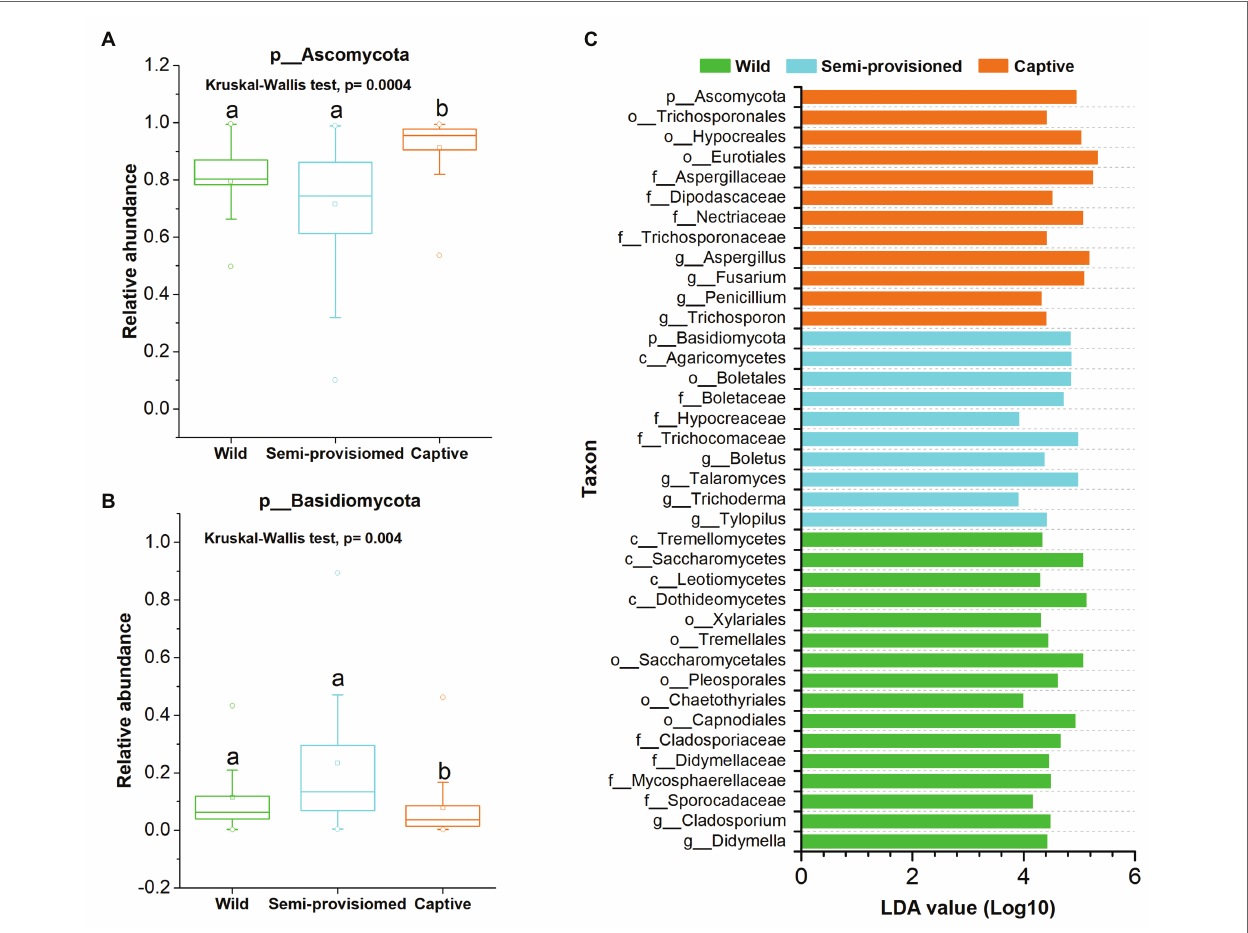
FIGURE 3 | Variation of fecal fungal taxonomy across three study groups. (A) Comparison of the dominant phyla Ascomycota. (B) Comparison of the dominant phyla Basidiomycota. A Kruskal-Wallis ANOVA test was used to evaluate the variation across treatment groups. Post hoc tests (Dunn’s test) for pairwise comparison tests (values of p were adjusted by Bonferroni). (C) Indicators of known fungal taxa in one of the three groups (at the genus, family, order, class, and phylum levels, the mean relative abundance of known taxa accounting for ≥ 1% of all the fecal sample), identified by linear discriminant analysis effect size (LEfSe) analysis (LDA > 3, p <